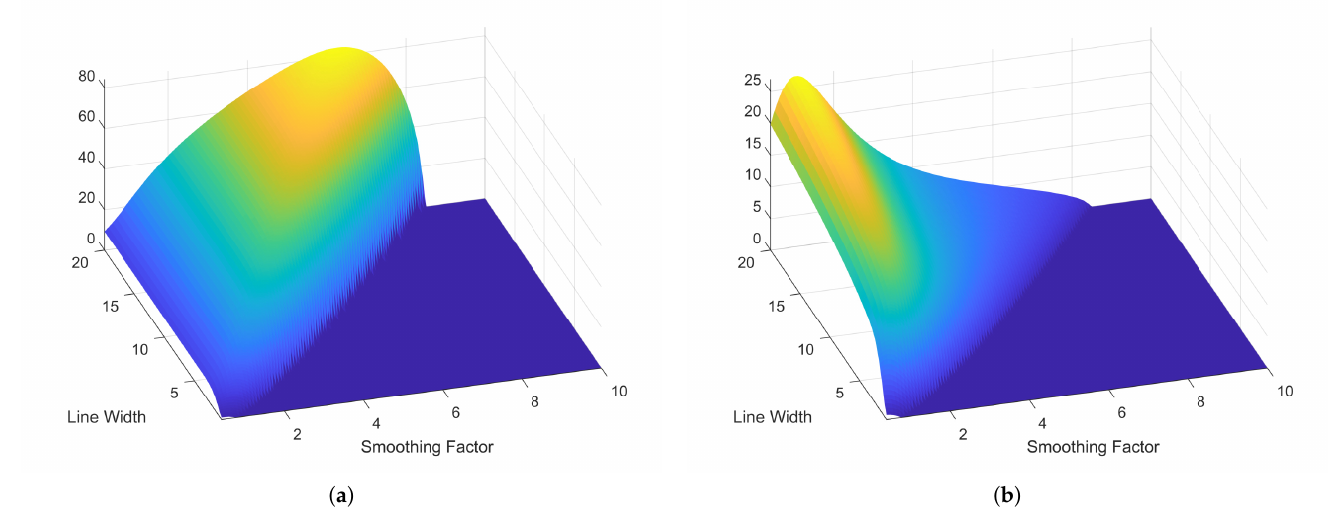
Figure 3. SNR C and SNR PS of edge detection. ( a ) SNR C (edge) and ( b ) SNR PS (edge).